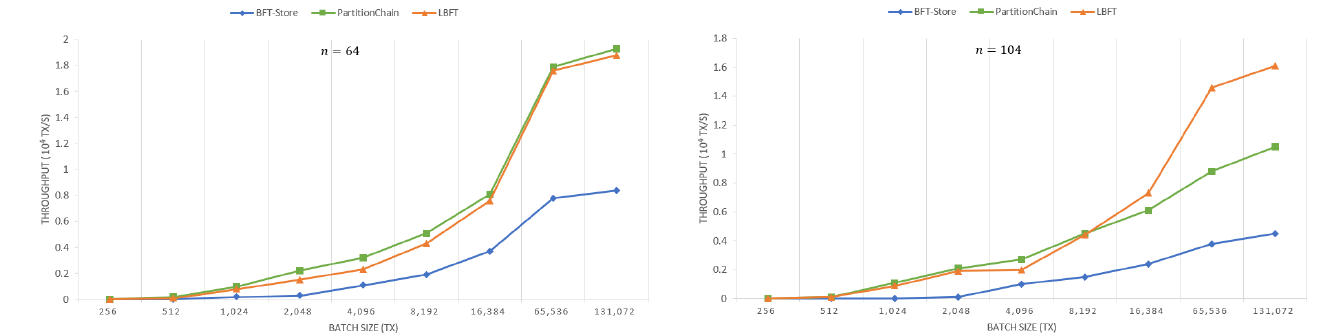
Figure 6. The system throughputs of LBFT, PartitionChain, and BFT-Store against the batch sizes when the number of nodes is n = 64 and n = 104.